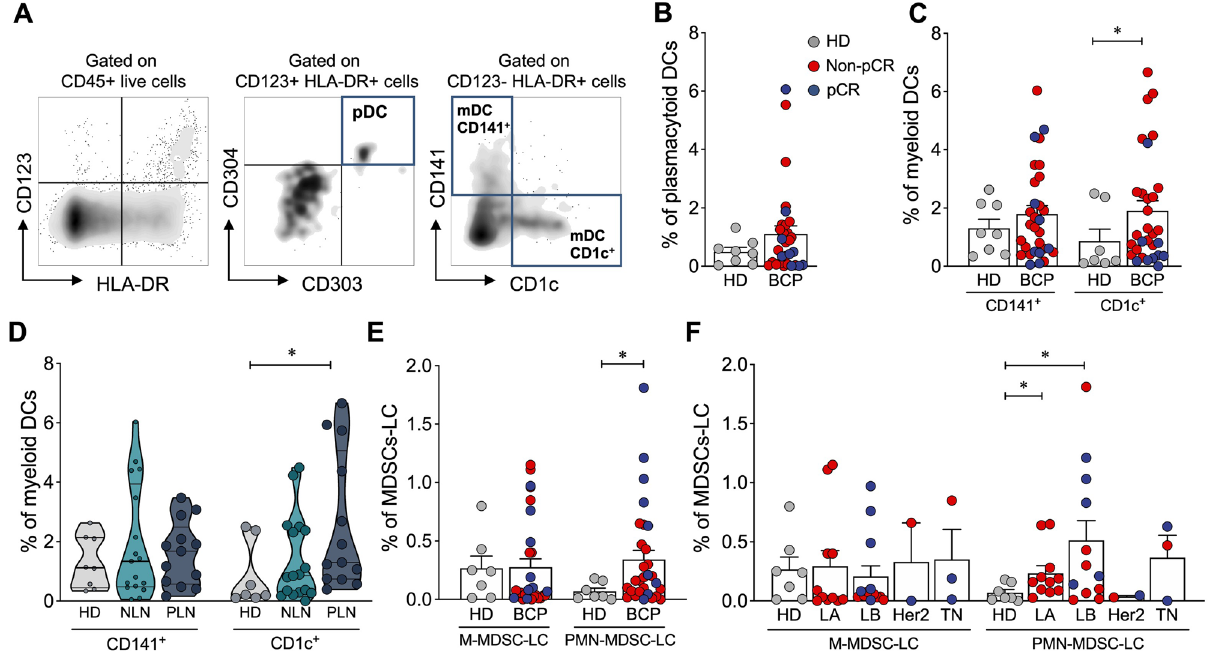
Figure 4. Immune composition in tumor and normal breast tissue. ( A ) Representative FACS analysis of plasmacytoid dendritic cells (pDCs) and CD141 + and CD1c + myeloid dendritic cells (mDCs). ( B ) Frequency of pDCs from HD and BCP. ( C ) Percentage of CD141 + and CD1c + myeloid DCs. ( D ) Frequency of CD141 + and CD1c + myeloid DCs from HD patients and patients with positive lymph nodes (PLNs) or negative lymph nodes (NLNs). ( E ) Frequency of monocytic MDSCs (M-MDSCs) and polymorphonuclear MDSCs (PMN-MDSCs). ( F ) Frequency of M-MDSCs and PMN-MDSCs according to the molecular subtype of breast cancer: luminal A (LA), luminal B (LB), Her2 and triple negative (TN). In all cases, each point represents independent samples: gray circles correspond to HD, blue circles to pathologic complete response (pCR) and red circles to non-pCR patients. Data are represented as the mean ± SEM. The p values were calculated using a Mann–Whitney test. * p < 0.05, ** p < 0.01, *** p < type of cancer, it was found that the distribution of T N cells was higher in TN patients than in the other groups (Fig. 3 G, H). Additionally, according to the pathologic response, the distribution of memory subpopulations of CD4 + T and CD8 + T cells was significantly different between HD and non-pCR patients, while the distribution